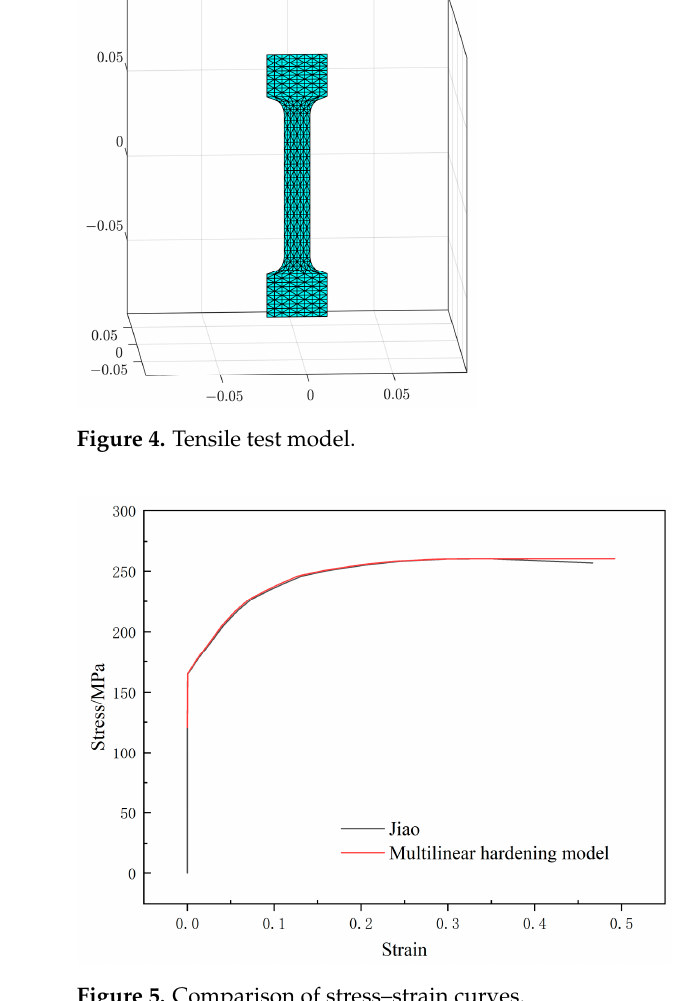
Figure 5. Comparison of stress–strain curves.